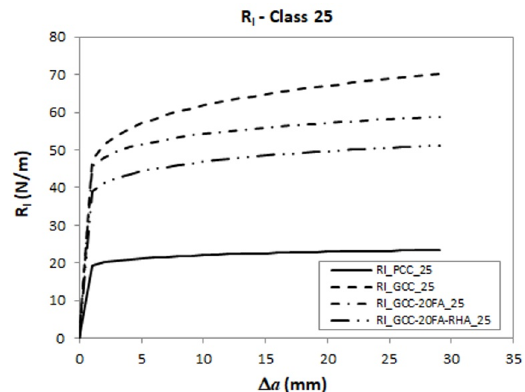
curves with the extension of the Figure 8. Variation of the R I crack for concrete notched beams of strength class of 25 MPa, with different matrices.